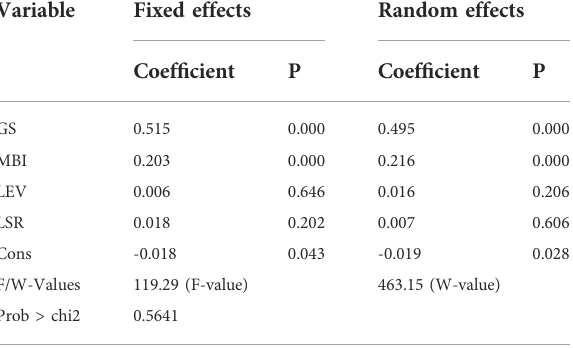
TABLE 5 Regression results for R&D investments.